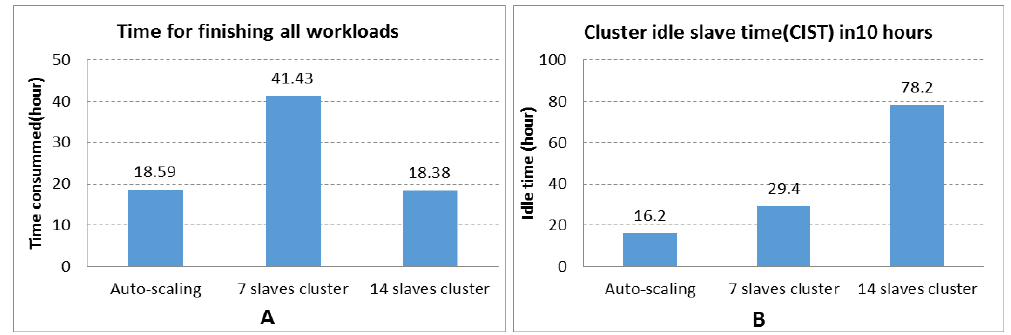
Figure 7. ( A ) Time consumed for finishing all workloads for each cluster. Time calculated by summing the 224 job finish times; ( B ) Cluster Idle Slave Time (CIST) for each cluster in the 10-hour period.